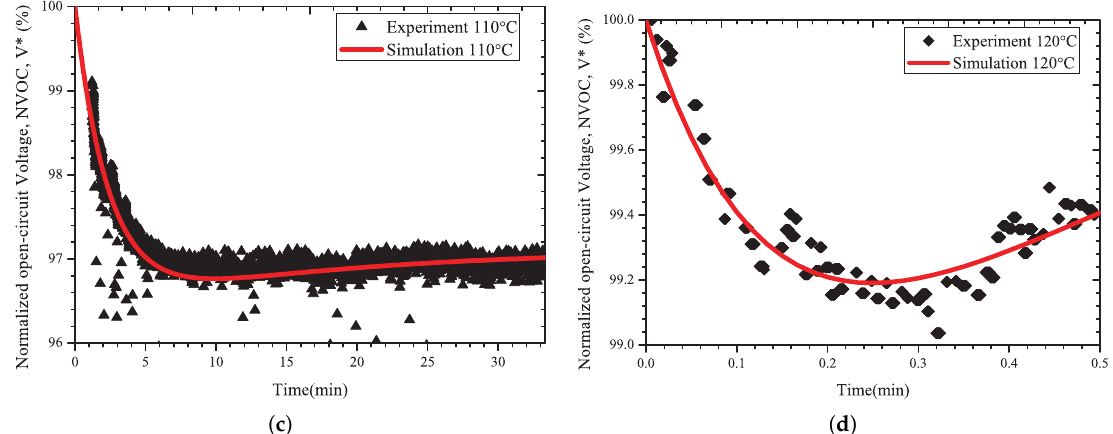
Figure 4. Real-time observation results of experiment on applying regeneration state to PERC solar cell module and cyclic reaction model simulation fitting. ( a ) Thermal image observation results of temperature distribution in one-cell PERC solar cell module subjected to remote heating using induction resonance circuit. Temperatures of ( b ) 85 ◦ C, ( c ) 110 ◦ C, and ( d ) 120 ◦